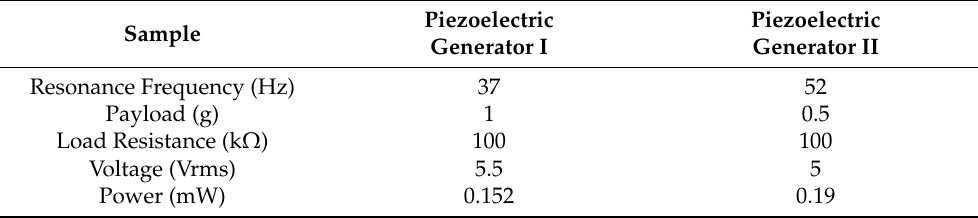
Figure 4. Fabrication and measurement of a single PG. ( a ) Piezo-generator, electric charging circuit, block capsulation, and measurement system; ( b ) Output voltage and power of a single PG (I and II) with payloads of 0.5 and 1.0 g. Table 3. Optimum conditions and performance of two piezoelectric cantilever generators.